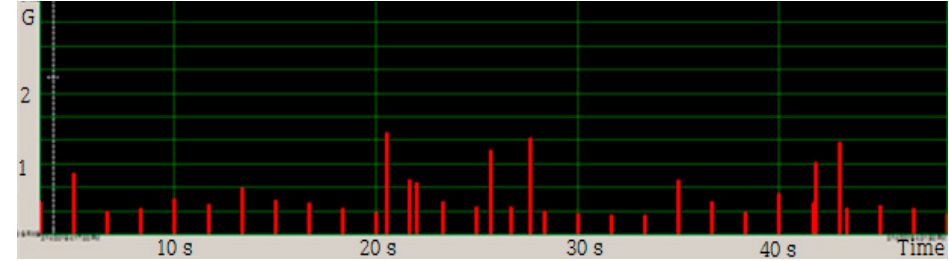
Figure 4. Vibration levels in the time and frequency domains.